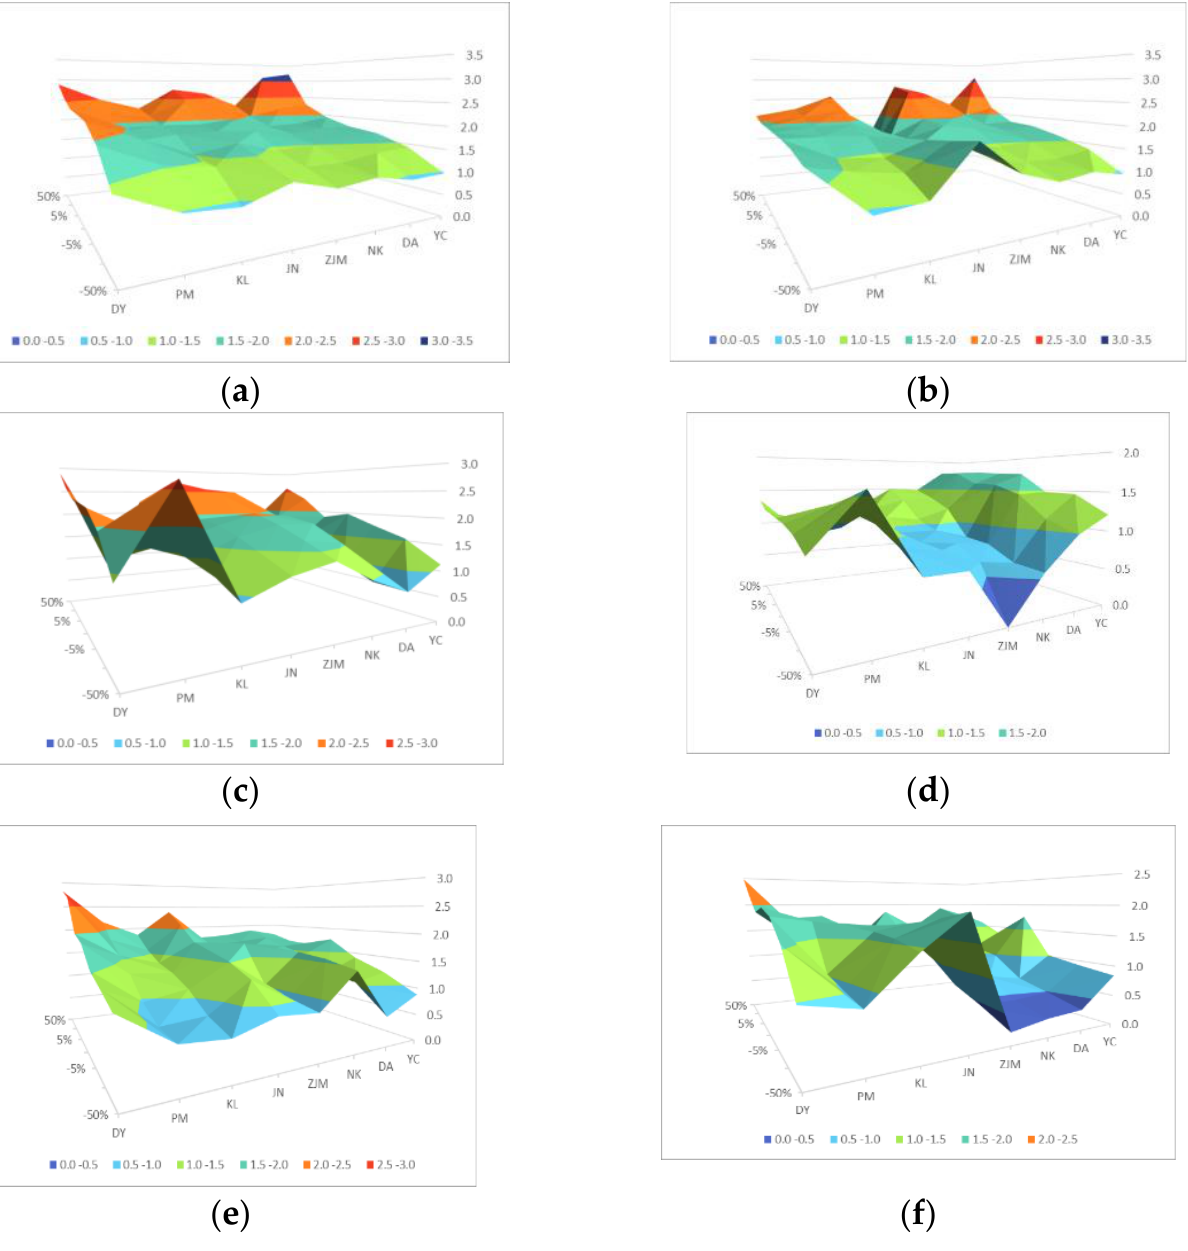
Figure 2. Sensitivity analysis result. ( a ) Q13 Sensitivity analysis result; ( b ) Q42 Sensitivity analysis result; ( c ) Q43 Sensitivity analysis result; ( d ) Q41 Sensitivity analysis result; ( e ) Q21 Sensitivity analysis result; ( f ) Q44 Sensitivity analysis result.